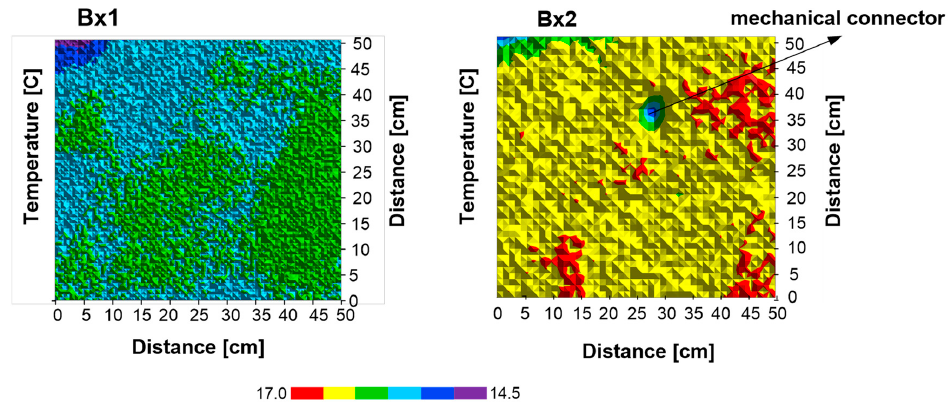
Figure 7. Temperature distribution on the surfaces Bx1 and Bx2.